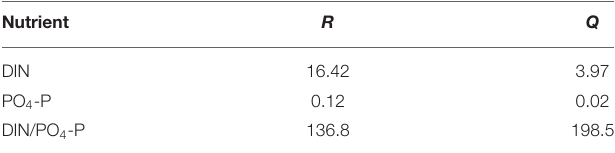
TABLE 2 | The nutrient concentrations ( µ mol L − 1 ) of seawater.